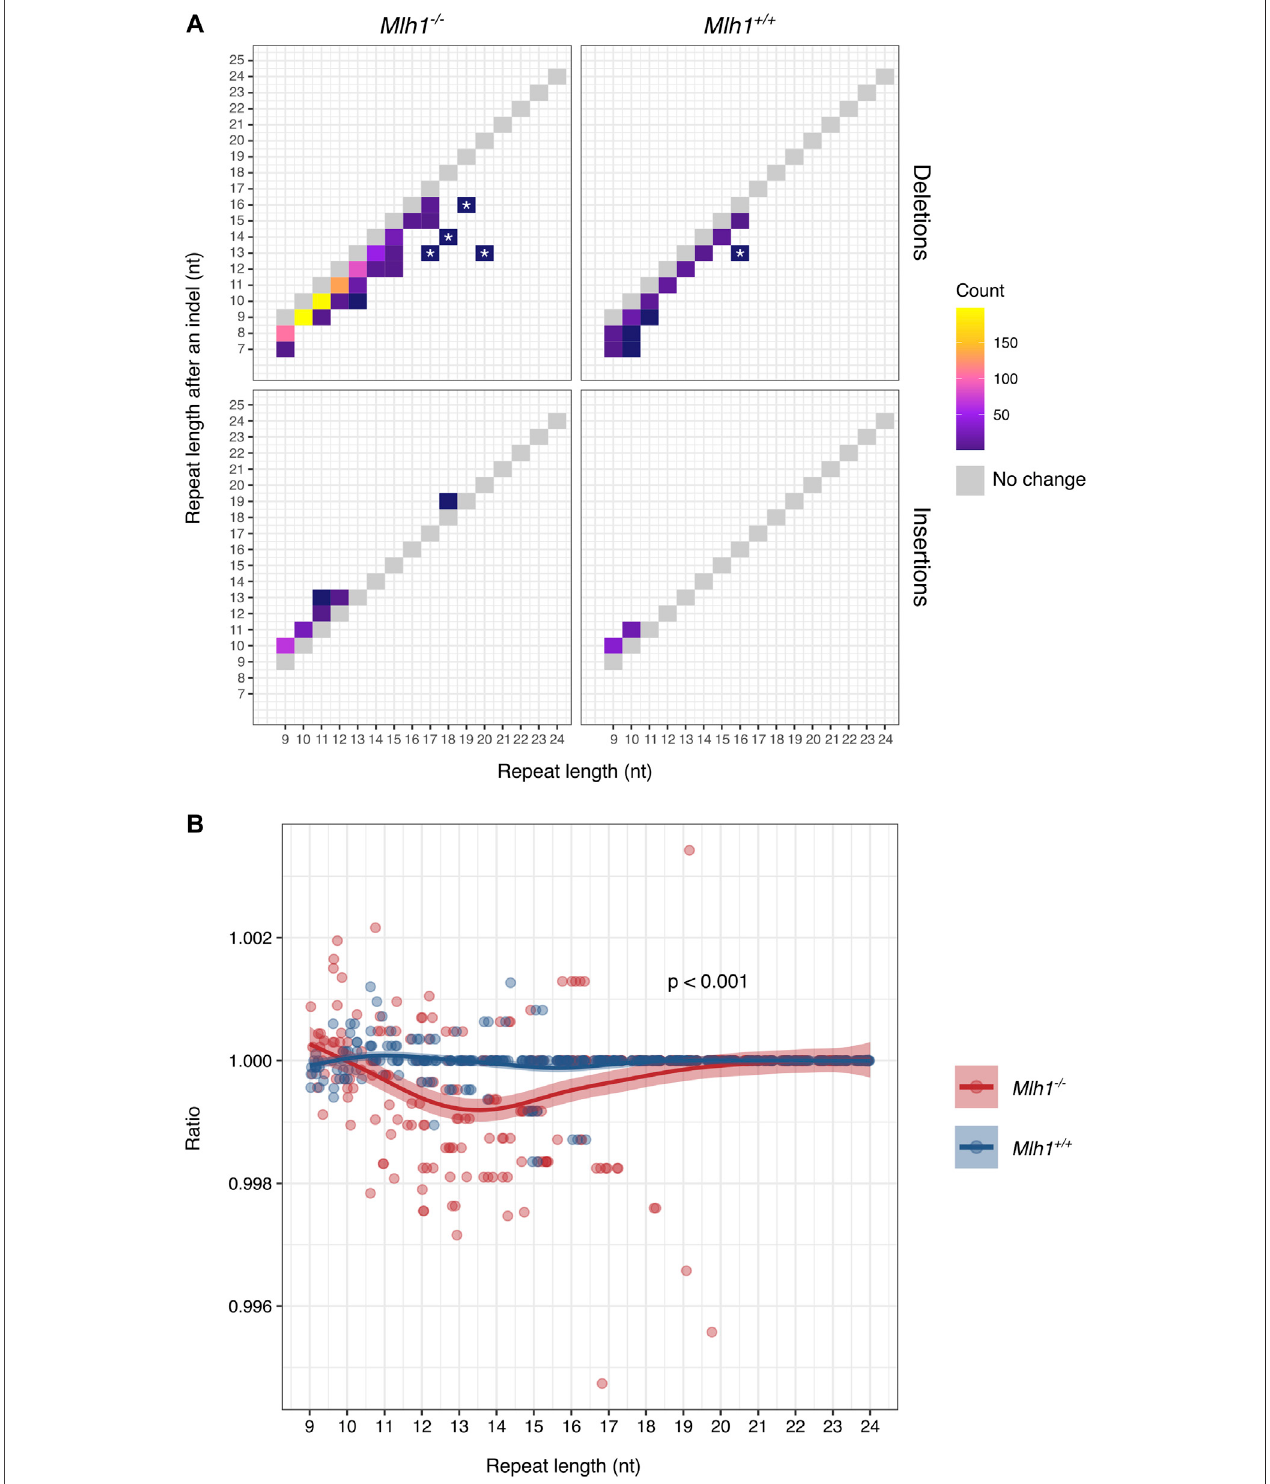
FIGURE 2 | Mononucleotide microsatellites mostly lose single repeat units in a stepwise manner. (A) Changes in mononucleotide repeat length as a result of deletions (upper panel) and insertions (lower panel). Single-nucleotide shifts account for most indels, while > 1-nt shifts are less common. Gray boxes indicate size of the unmutatedrepeat.Largeshiftsprivateforasinglecellaremarkedwithasterisks. (B) Changeinmononucleotiderepeatlengthsafterindelsaffectstheexome-widerepeat